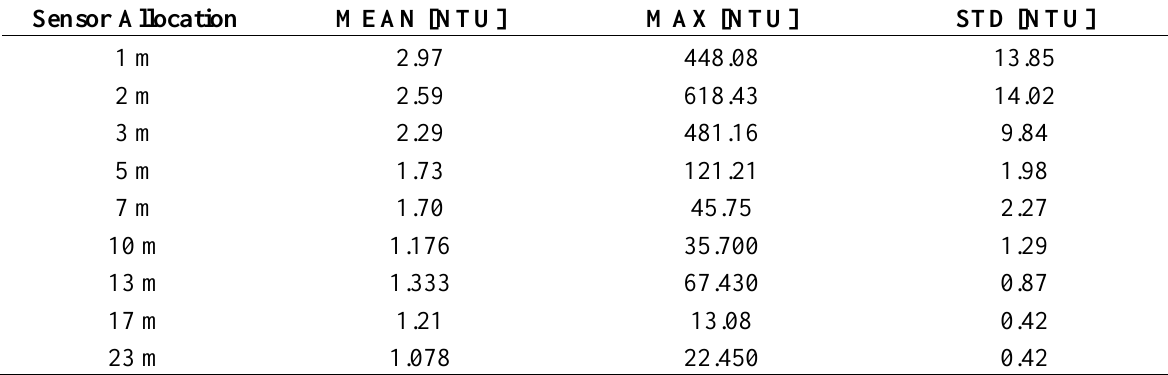
Table 3. Primary statistical characteristics of turbidity data collected from sensors in all monitoring depths for the entire observation period (n =